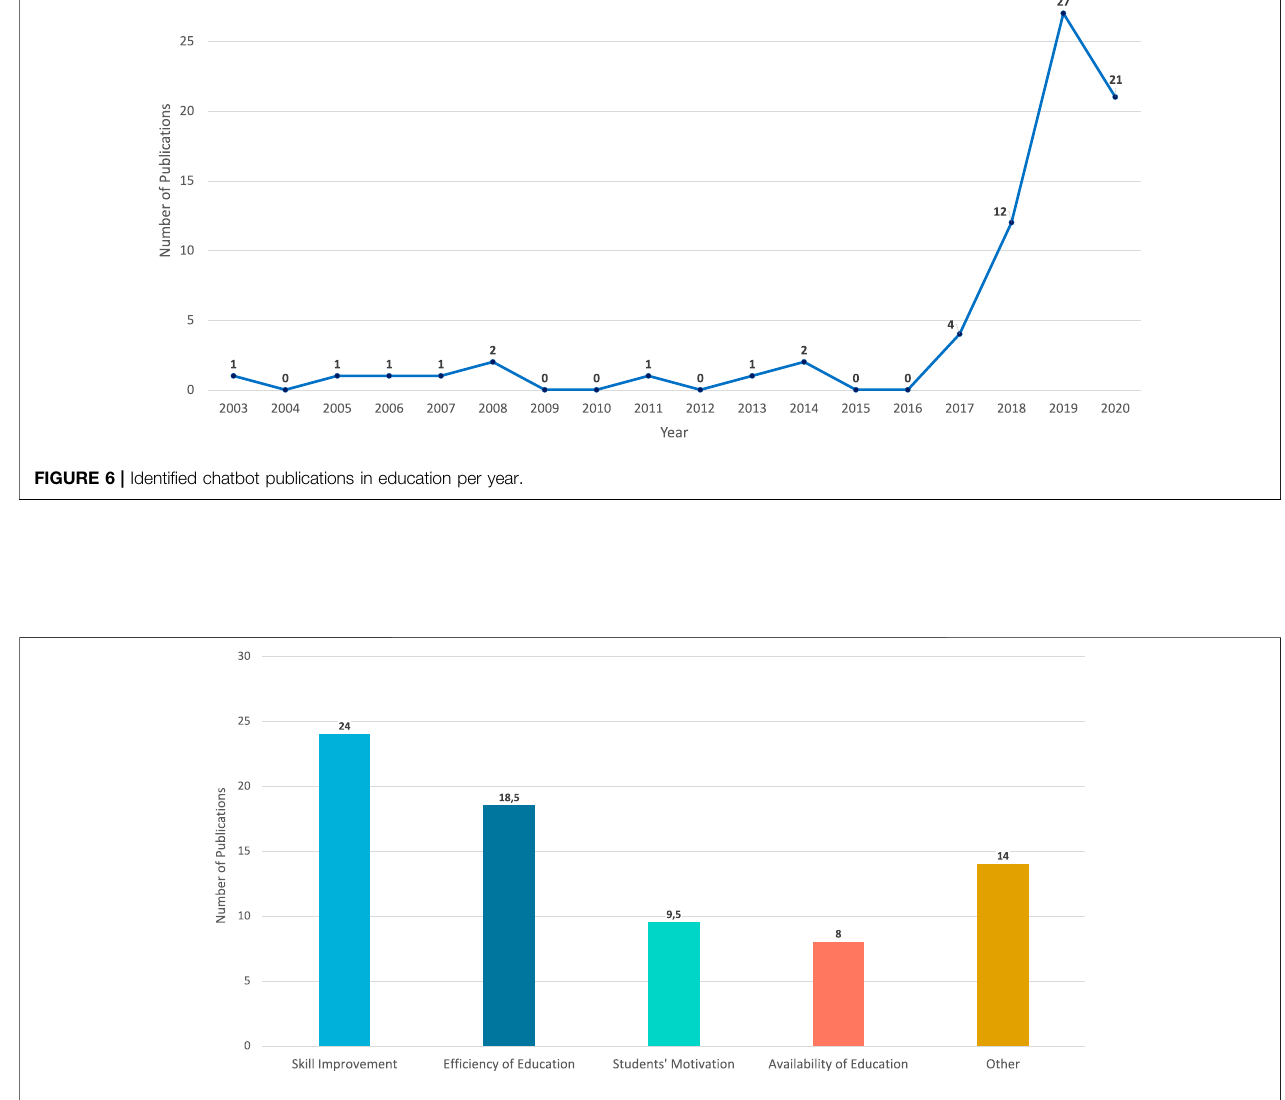
FIGURE 7 | Objectives for implementing chatbots identi fi ed in chatbot publications.